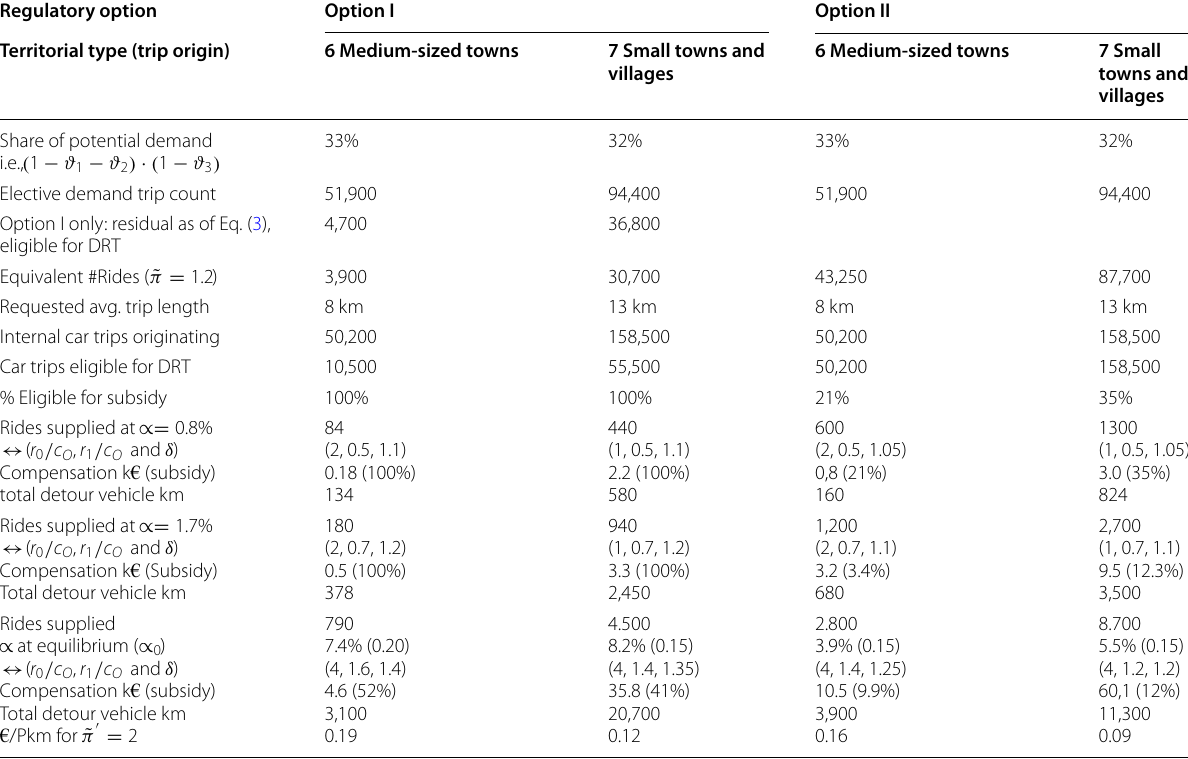
Table 4 Comparison of regulatory options and territory types for an average operating day Regulatory